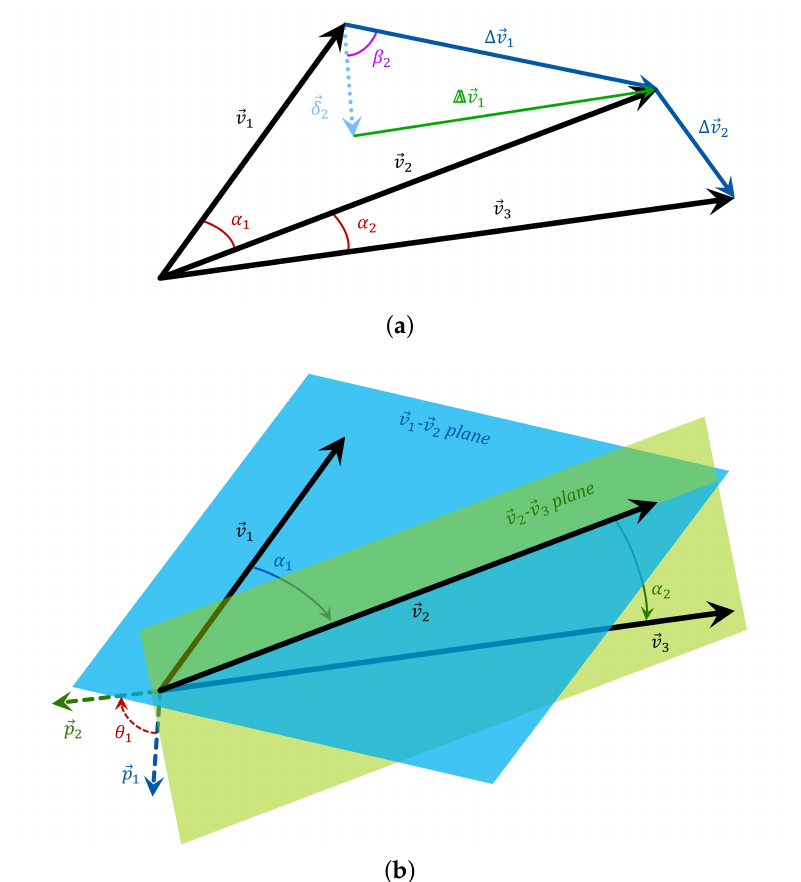
Figure 1. Graphical illustration of the selected axes of the heuristic orientation-invariant transformation (OIT). The geometric features of three sequential measurements (cid:126) v 1 , (cid:126) v 2 , (cid:126) v 3 in 3-D space are shown. The first- and second-order difference sequences, the angles between successive measurement vectors, and the angles between successive difference vectors are shown in ( a ); The rotation axes and the angles between them are illustrated in ( b